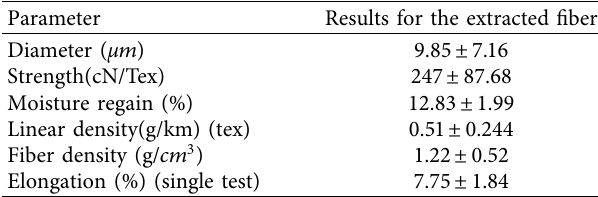
Table 1: Physical properties of